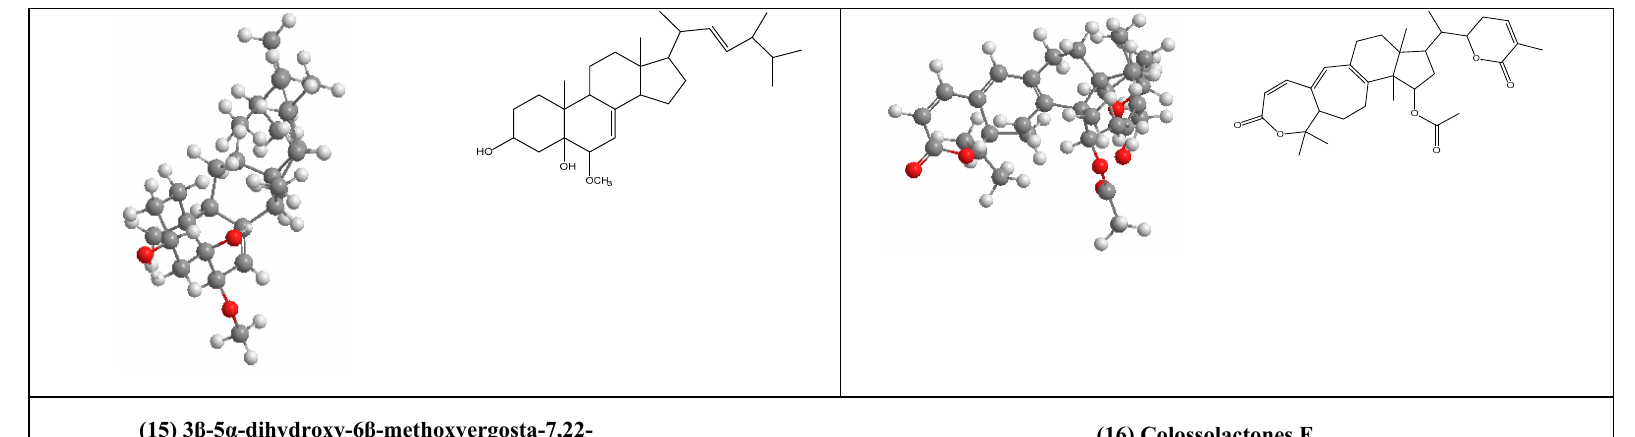
Figure 4. The 2D and 3D chemical structures of virus protease inhibitors.